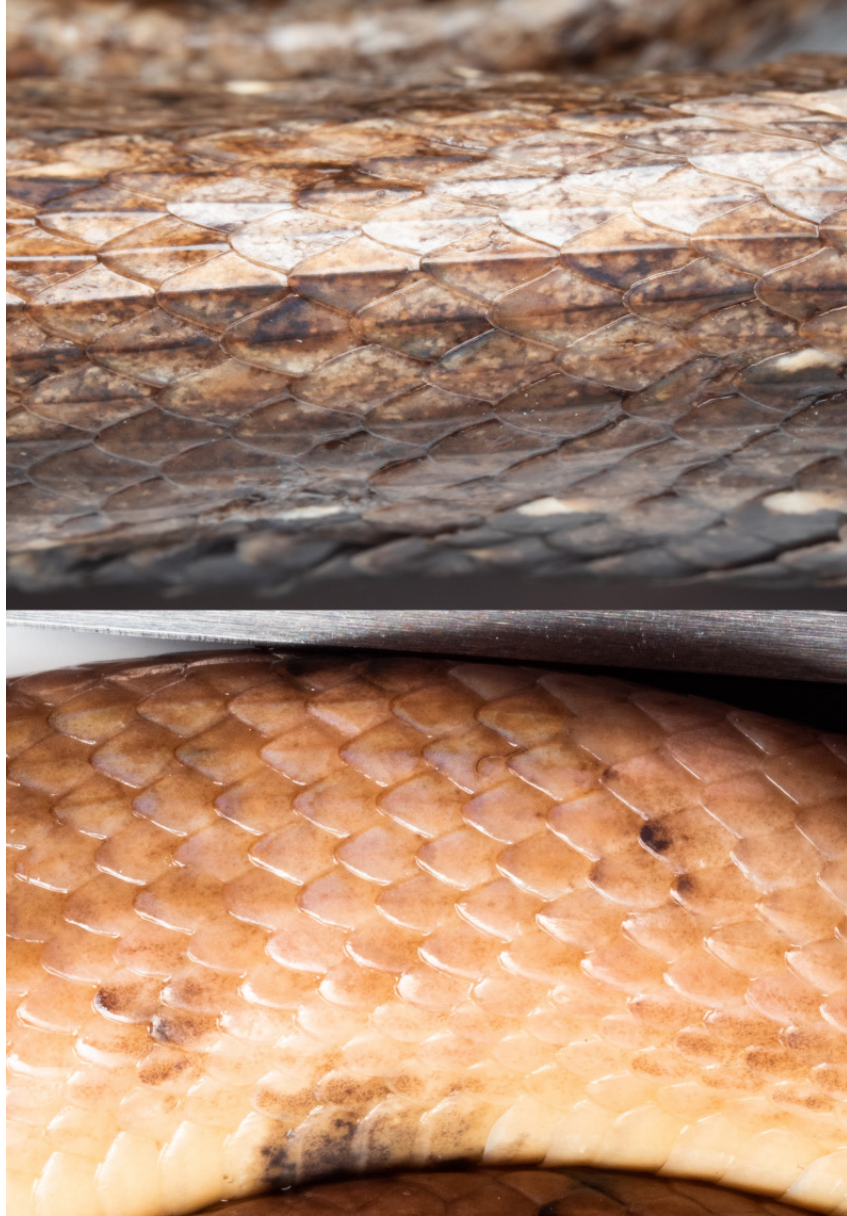
Fig. 16. Distinction in dorsal keel character states, well developed in Tropidophis taczanowskyi (Steindachner, 1880) (top, DHMECN 16391), and inconspicuous or absent in Tropidophis cacuangoae sp. nov. (bottom, DHMECN